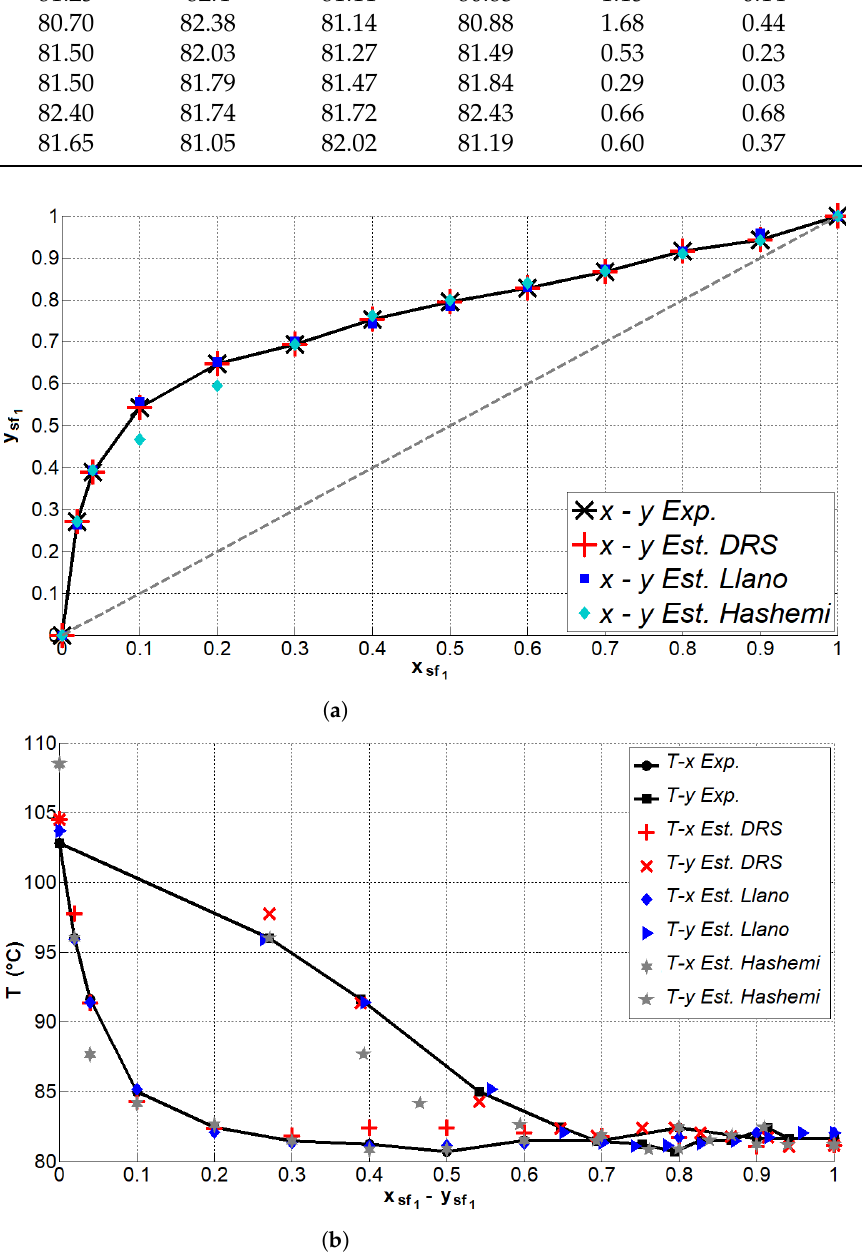
Figure 2. VLE expressed on a salt-free basis of ethanol–water–CaCl 2 system. ( a ) xy diagram; where the gray dotted line is the reference between the phases of the mixture. ( b ) Txy